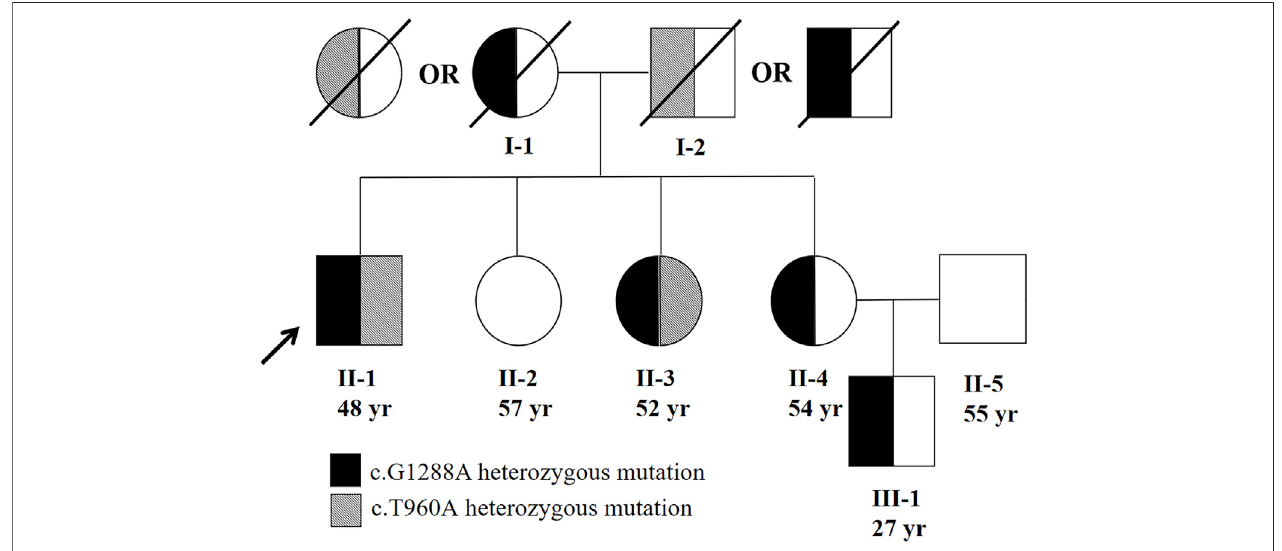
FIGURE 4 | Family pedigree of patient. The parents of the proband should each had a heterozygous mutation (c.960T ＞ A or c.G1288A). The proband ’ s parents were not